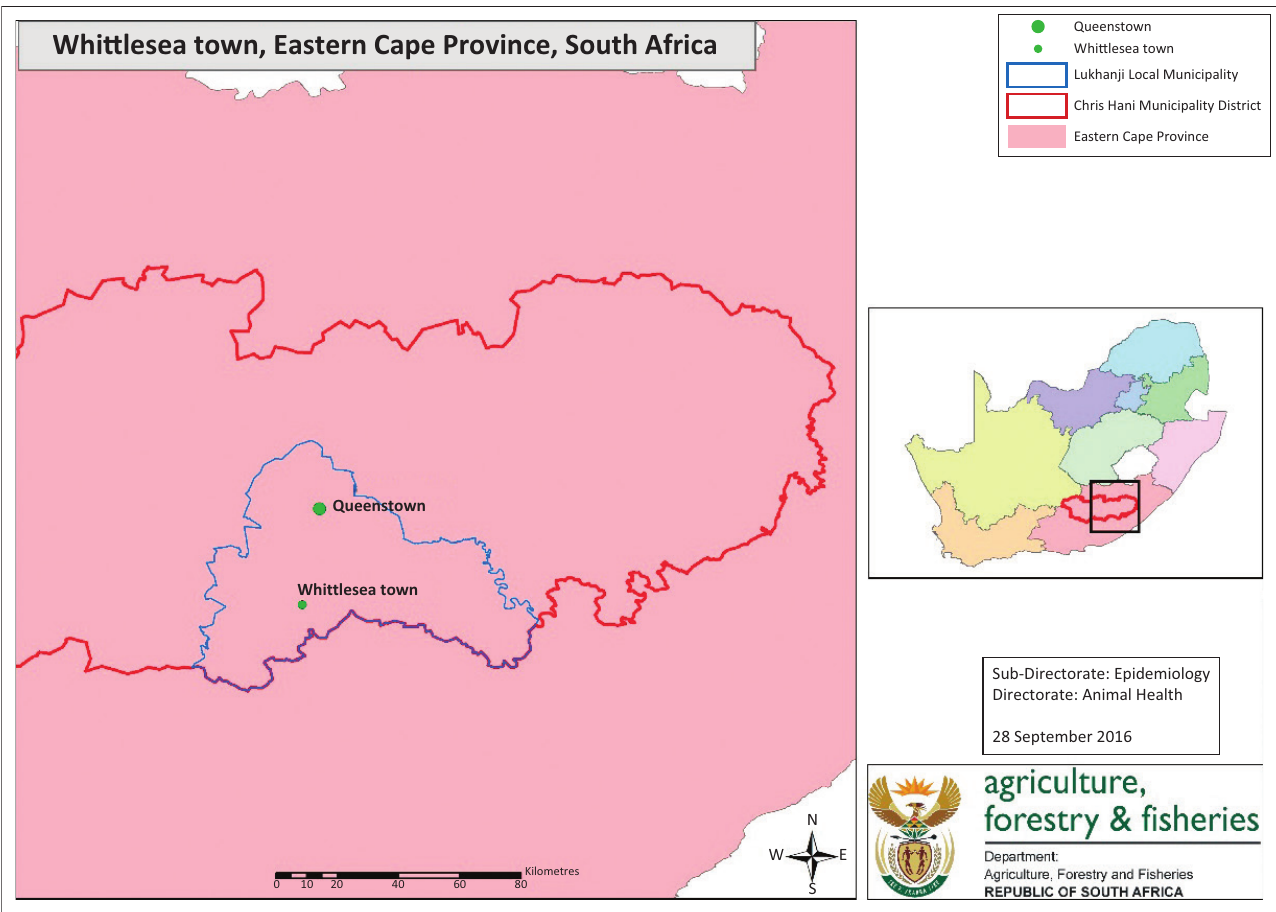
Source : Figure courtesy of DAFF, Directorate Animal Health (Sub-Directorate: Epidemiology) FIGURE 1: Location of the Lukhanji municipal area of the Chris Hani district in the Eastern Cape Province of South